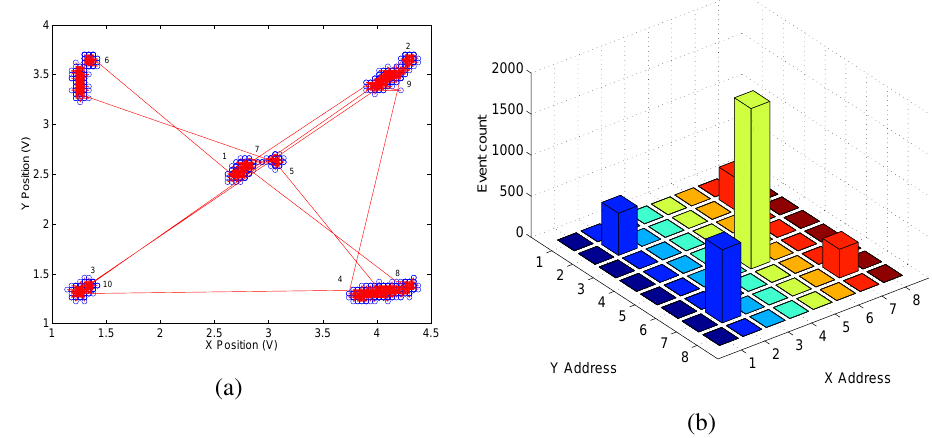
Figure 12 . (a) Output of the P2V circuits of the selective attention architecture measured over a period of 300ms, in response to a test stimulus exciting four corners of the input array at a rate of 30Hz and a central cell at a rate of 50Hz; (b) Histogram of the chip’s output address-events, captured over a period of 13.42s in response to the same input